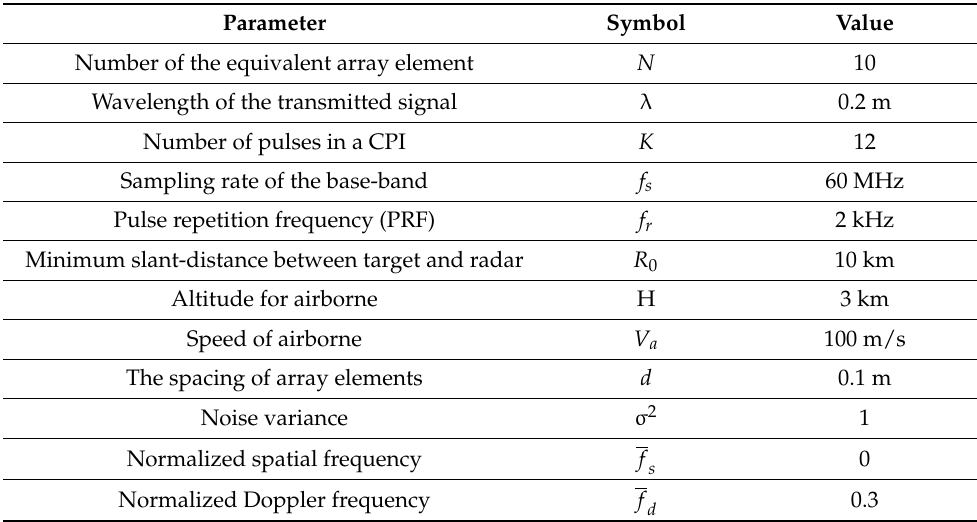
Table 1. Radar system simulation